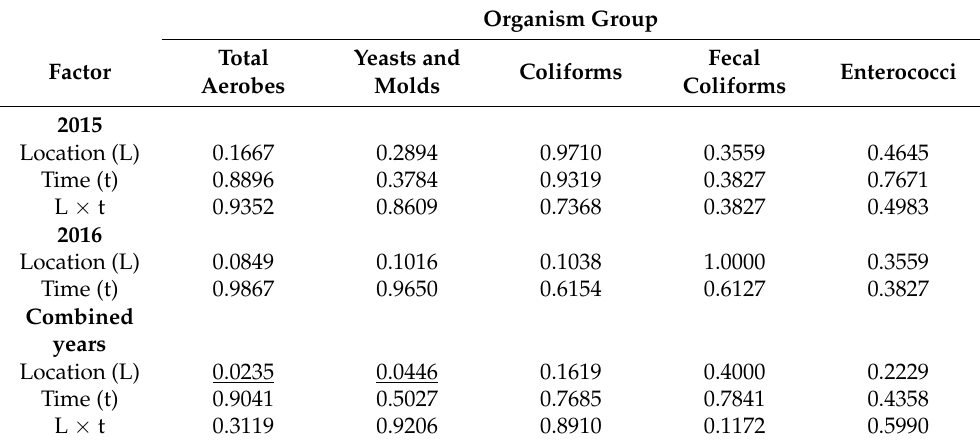
Table 4. p -values of mixed-model analysis of variance for the effects of fruit sampling location (before entering or after leaving the harvester) and time (AM, noon, PM) on the population density (log 10 ( x + 1) colony-forming units per g of fruit) of environmental and fecal indicator organisms across seven mechanical blueberry harvesters in each of 2015 and 2016 1